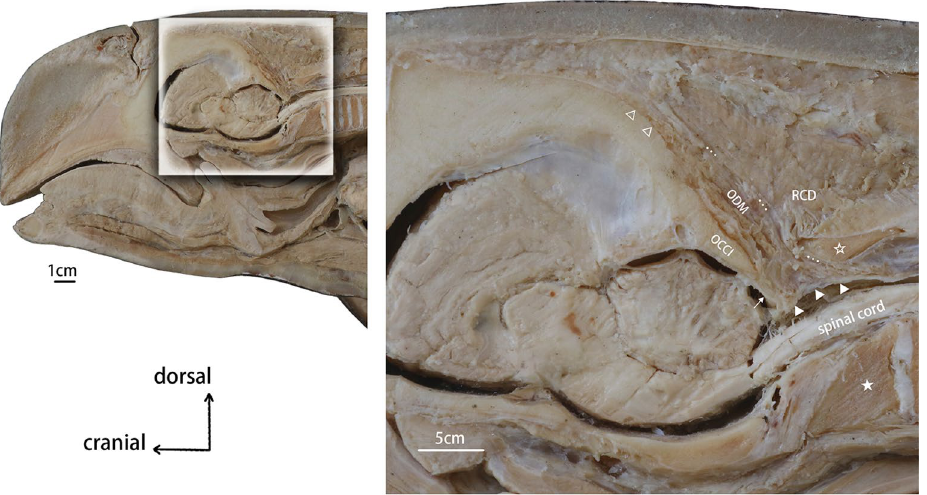
Figure 3. Sagittal section dissection of the suboccipital region of the N.asiaeorientalis. OCCI: occiput. RCD: rectus capitis dorsalis. ODM: occipital-dural muscle. : the fused vertebral body of the first three vertebrae. ☆ : the fused spinous process. △ : the origination of the occipital-dural muscle. ▲ : termination of the occipital-dural ★ muscle. …: boundary of the occipital-dural muscle. ↑ : cerebral dura